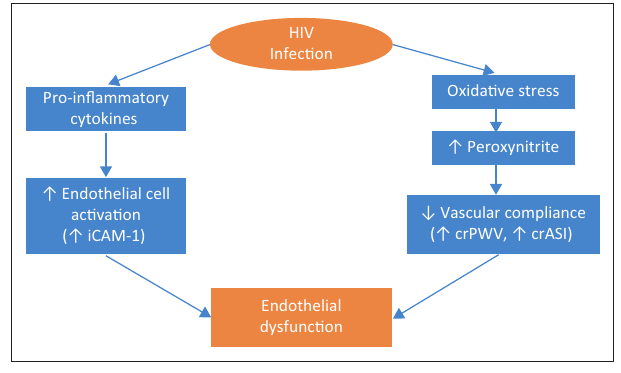
FIGURE 2 : Summary of contribution of endothelial activation and oxidative stress to endothelial